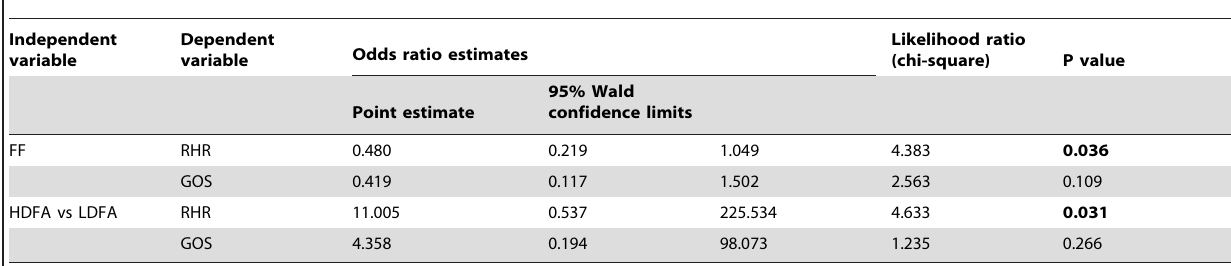
Table 5. Supplementary univariate regression analysis of IFA